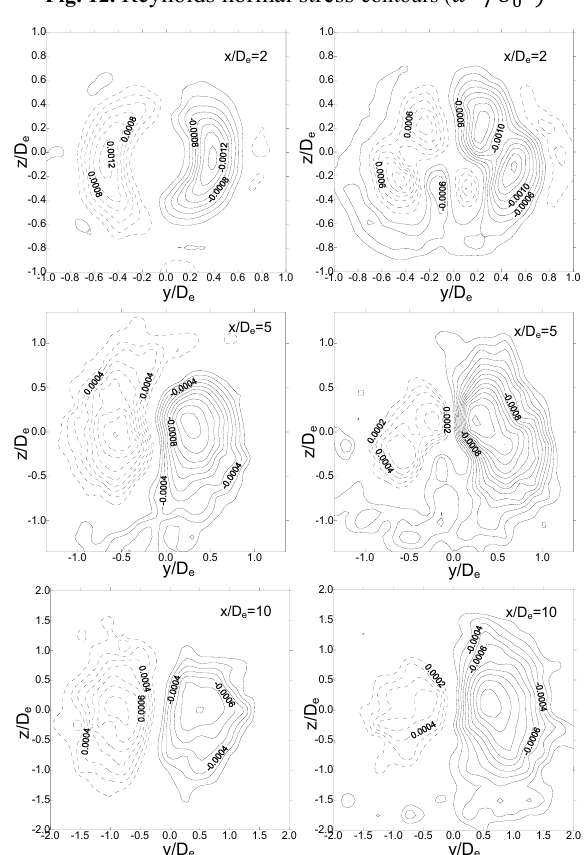
Fig. 13. Reynolds shear stress contours ( ̅̅̅̅̅